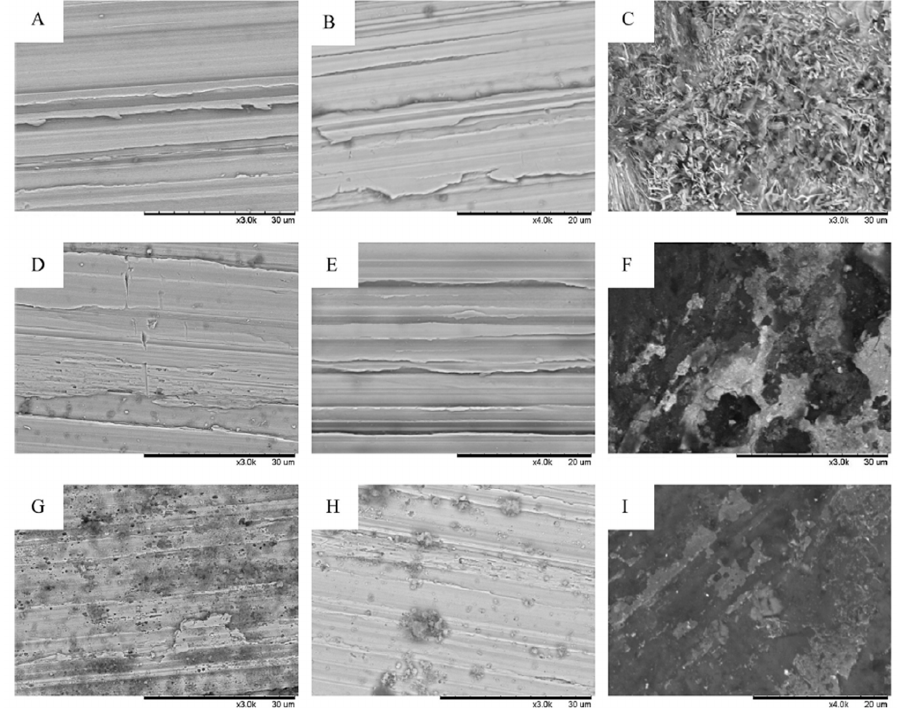
Figure 9. Surface morphology of ASTM 1045 MS in 0# diesel at different temperatures 27, 50 and 80 °C for different exposure periods: ( A ) 27 °C —30 d; ( B ) 50 °C —30 d; ( C ) 80 °C —30 d; ( D ) 27 °C —60 d; ( E ) 50 °C —60 d; ( F ) 80 °C —60 d; ( G ) 27 °C —120 d; ( H ) 50 °C —120 d; ( I ) 80 °C —120 d [66].